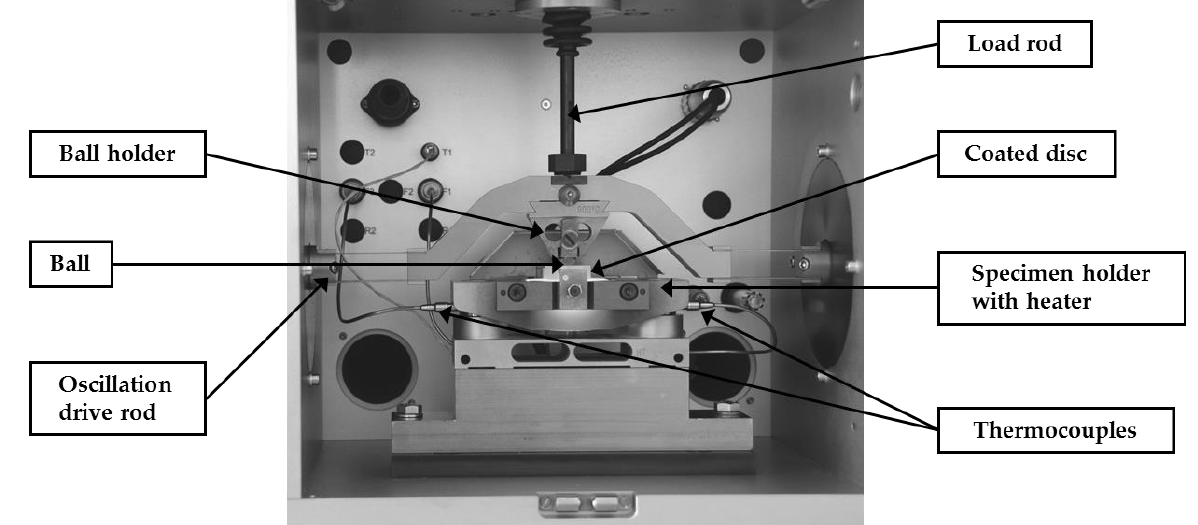
Figure 6. The oscillating ball-on-disc SRV tribosystem.